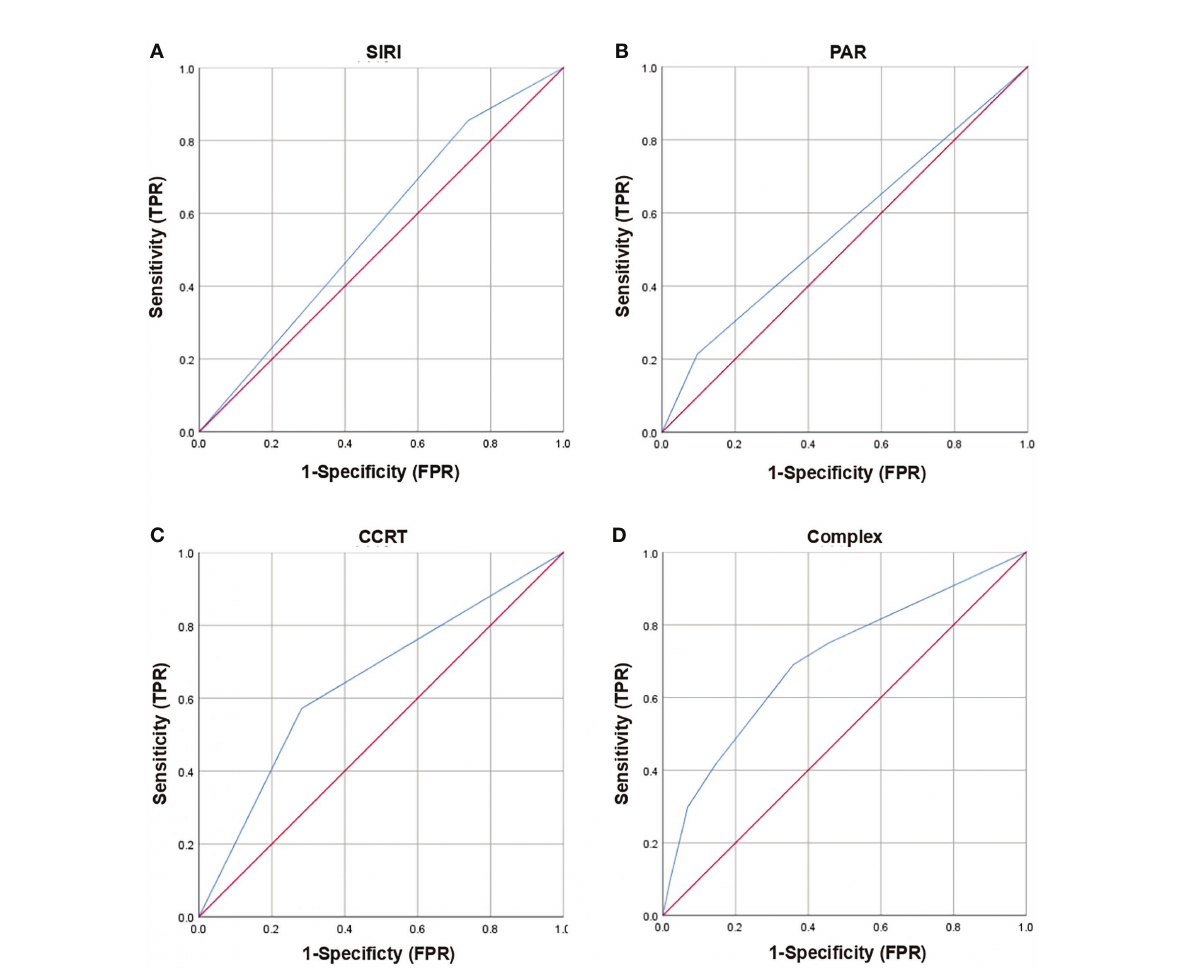
FIGURE 1 Receiver operating characteristic (ROC) curves of clinical and dosimetric factors (CCRT), in fl ammation index (SIRI, PAR) and complex (SIRI, PAR, CCRT) for grade ≥ 2 RE. (A) ROC curves of SIRI; (B) ROC curves of PAR; (C) ROC curves of CCRT; (D) ROC curves of Complex (SIRI, PAR, CCRT); RE, radiation esophagitis; SIRI, system in fl ammation response index; PAR, platelets-albumin ratio; CCRT, concurrent chemoradiotherapy; TPR, true positive rate; FPR, false positive